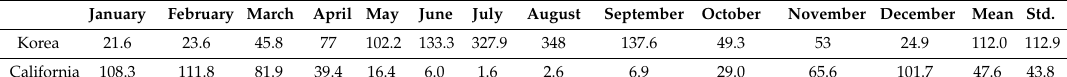
Table 4. Monthly mean precipitation in Korea and California (unit: mm ) [32].